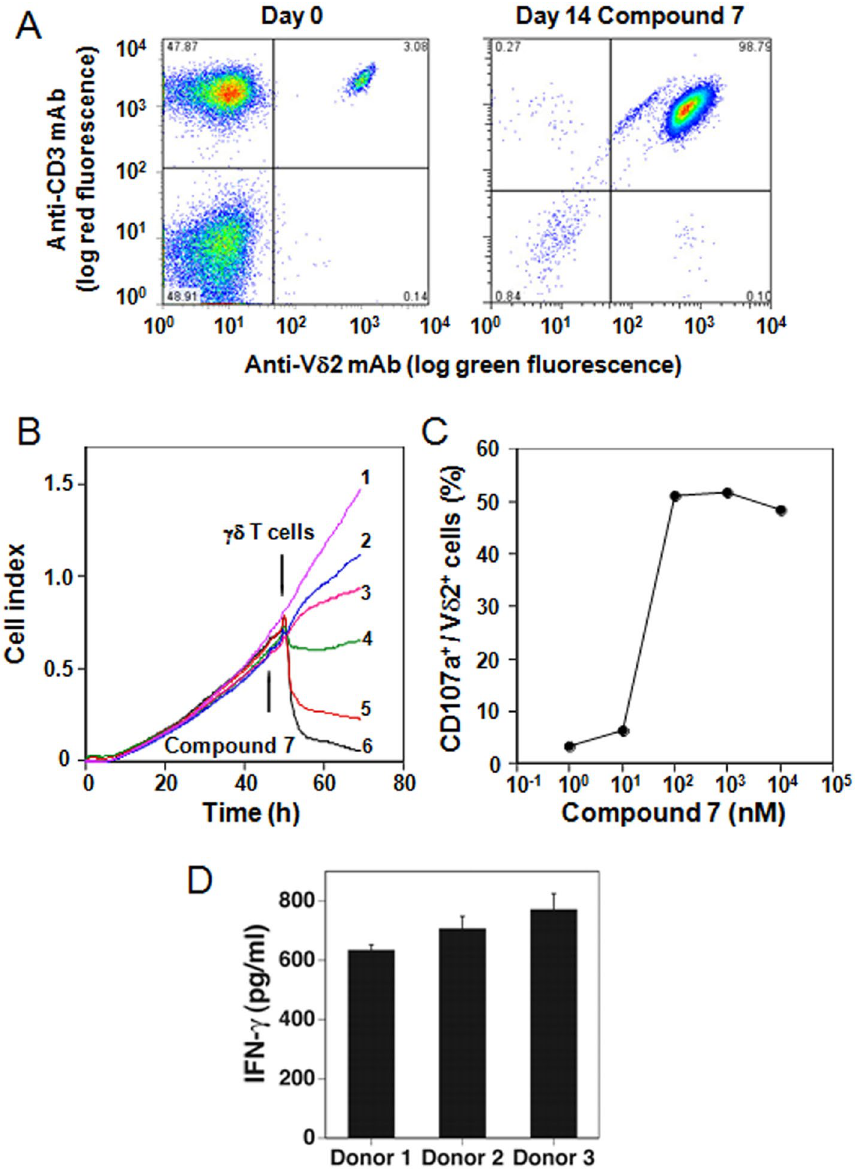
Figure 5. Selective activation of V γ 2V δ 2 T cells by compound 7 . ( A ) Selective expansion of V γ 2V δ 2 T cells from blood αβ and γδ T cells after culture with compound 7 . PBMC from a prostate cancer patient were stimulated with 1 μ M compound 7 and IL-2. The two-color flow cytometric analysis of V γ 2V δ 2 T cells in PBMC before (left panel) and after (right panel) 10 day stimulation is shown. ( B ) Inhibition of EJ-1 bladder carcinoma cell growth by exposure to compound 7 and γδ T cells. Compound 7 was added to cultures of EJ-1 tumor cells followed by the addition of V γ 2V δ 2 T cell to some cultures16 h later. Cell growth was assessed in a real-time cell analyzer system. Culture conditions were: (1) 50 nM compound 7 + medium, (2) 0 nM compound 7 + γδ T cells, (3) 1.56 nM compound 7 + γδ T cells, (4) 12.5 nM compound 7 + γδ T cells, (5) 25 nM compound 7 + γδ T cells, (6) 50 nM compound 7 + γδ T cells. ( C ) Degranulation of γδ T cells in response to U937 histocytoma pretreated with compound 7 . The proportion of CD107a + degranulated V δ 2 + cells were plotted against the concentrations of compound 7 used for the pretreatment of U937 cells. ( D ) Stimulation of IFN- γ production by V γ 2V δ 2 T cells by compound 7 . PBMC from healthy donor were cultured with 1 μ M compound 7 . After 48 h, the culture supernatants were removed and IFN- γ levels determined by